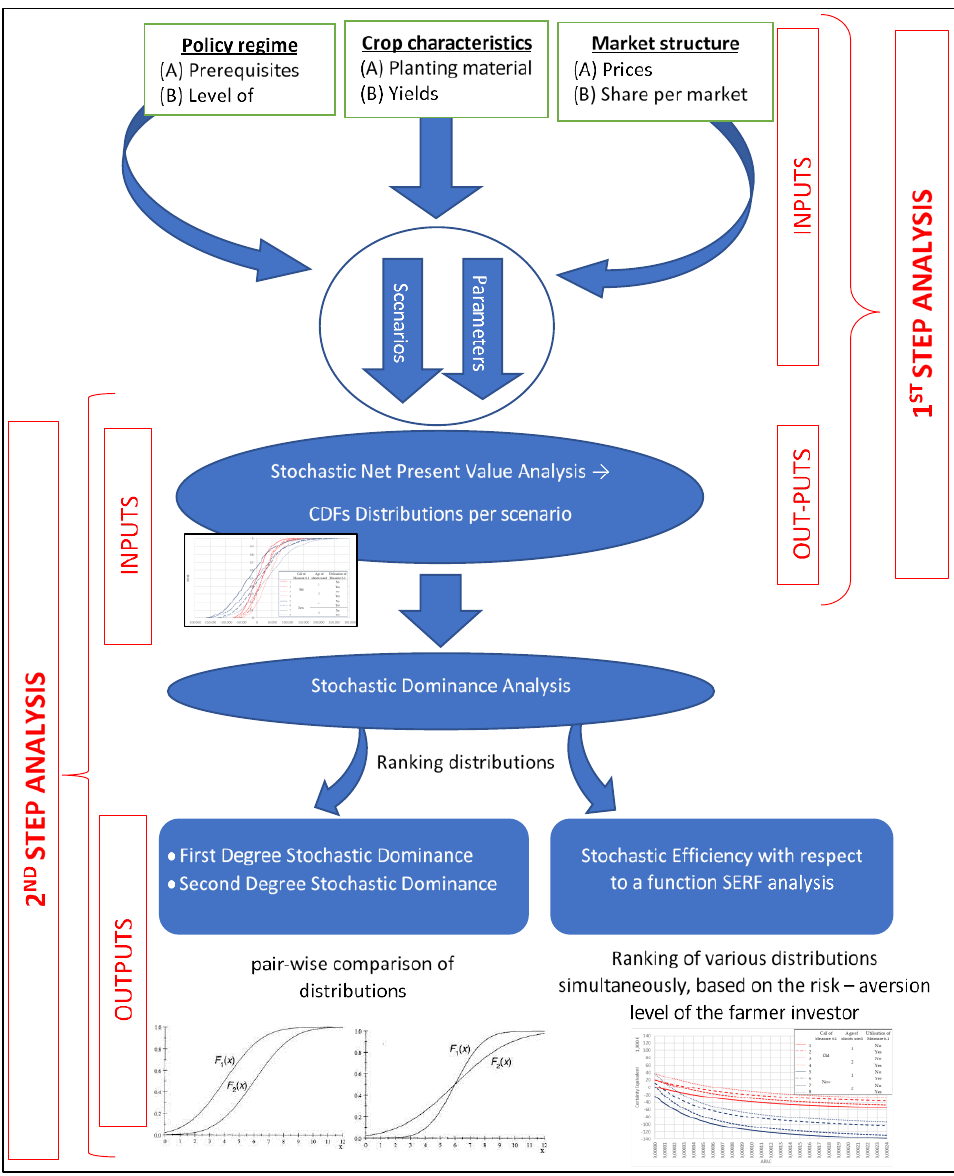
Figure 1. Methodological framework (source: own elaboration).